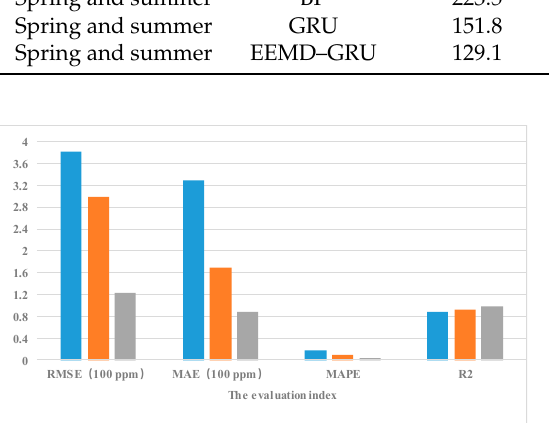
Figure 10. Comparison of prediction errors during autumn and winter.